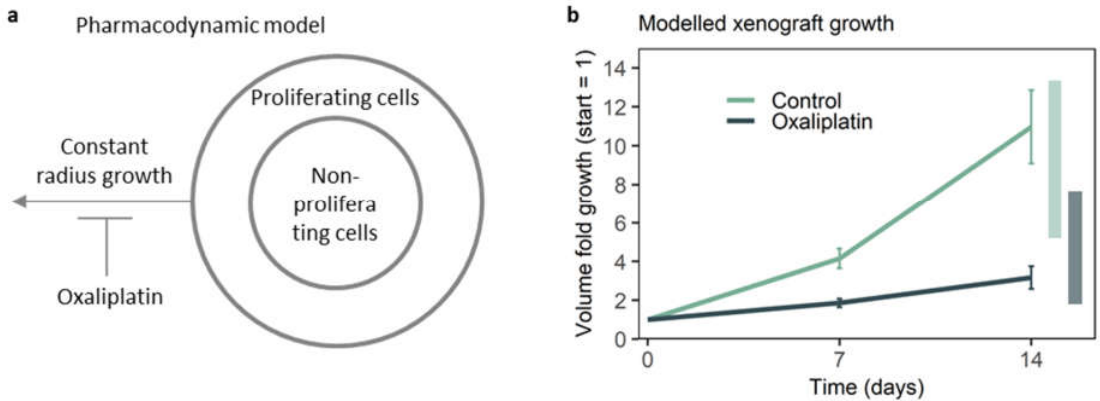
Figure 4. The pharmacodynamic model of HCT116 xenograft growth. ( a ) The modeled xenograft consisted of a shell of proliferating cells. Constant radius growth was derived from on-chip spheroid growth and the thickness of the proliferating shell in untreated HCT xenografts (see text). ( b ) Modeled growth with and without treatment. Error bars represents the standard error of the mean (SEM), based on individual growth found in n = 4 chips per condition. Shaded bars on the right represent the range found in xenograft studies [26,29–34].